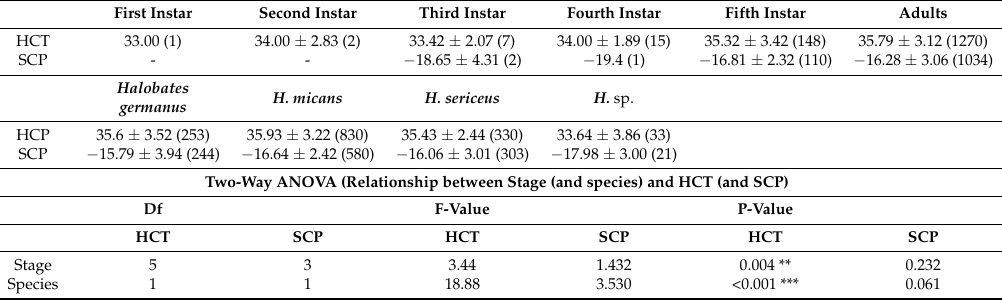
Figure 2. Negative correlation between heat coma temperatures (HCTs) and super cooling points (SCPs) in each of four species of oceanic sea skaters— Halobates micans ( A ), H. germanus ( B ), H. sericeus ( C ), and H. sp ( D )—inhabiting the temperate to tropical region of the Indian and Pacific Oceans.